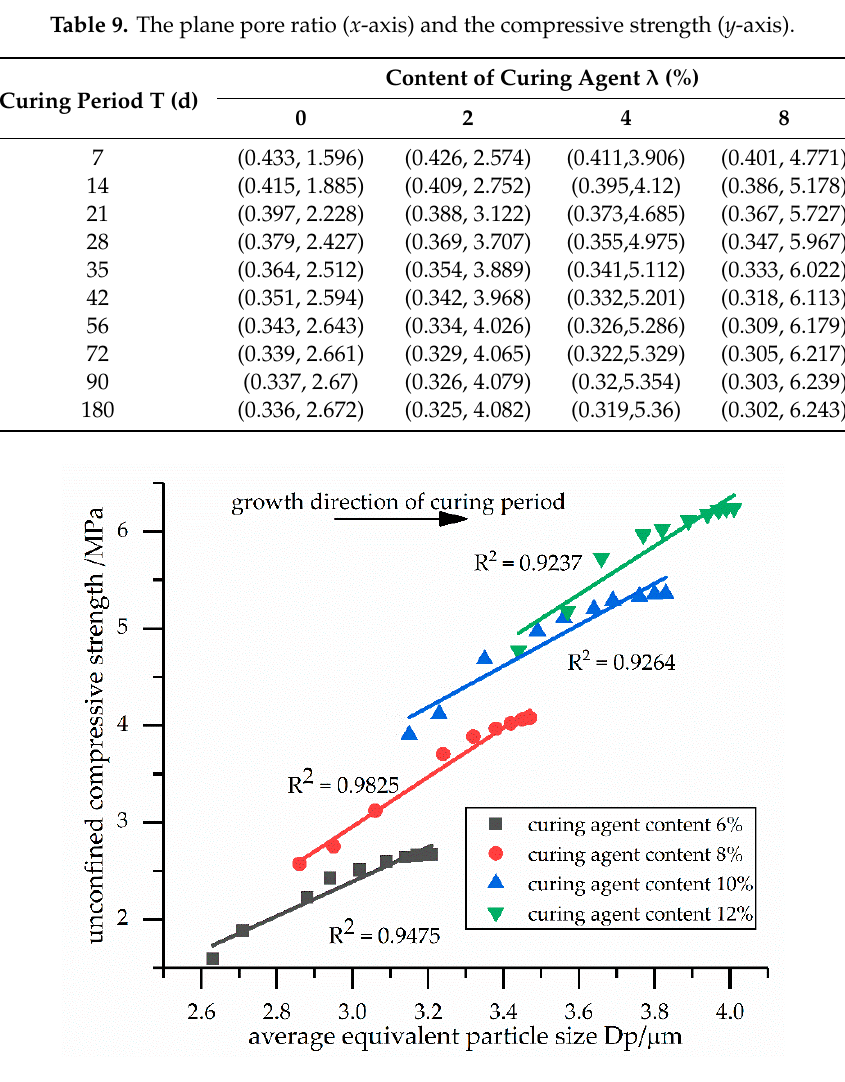
Table 10. Linear dependence of the unconfined compressive strength and the average equivalent particle size.